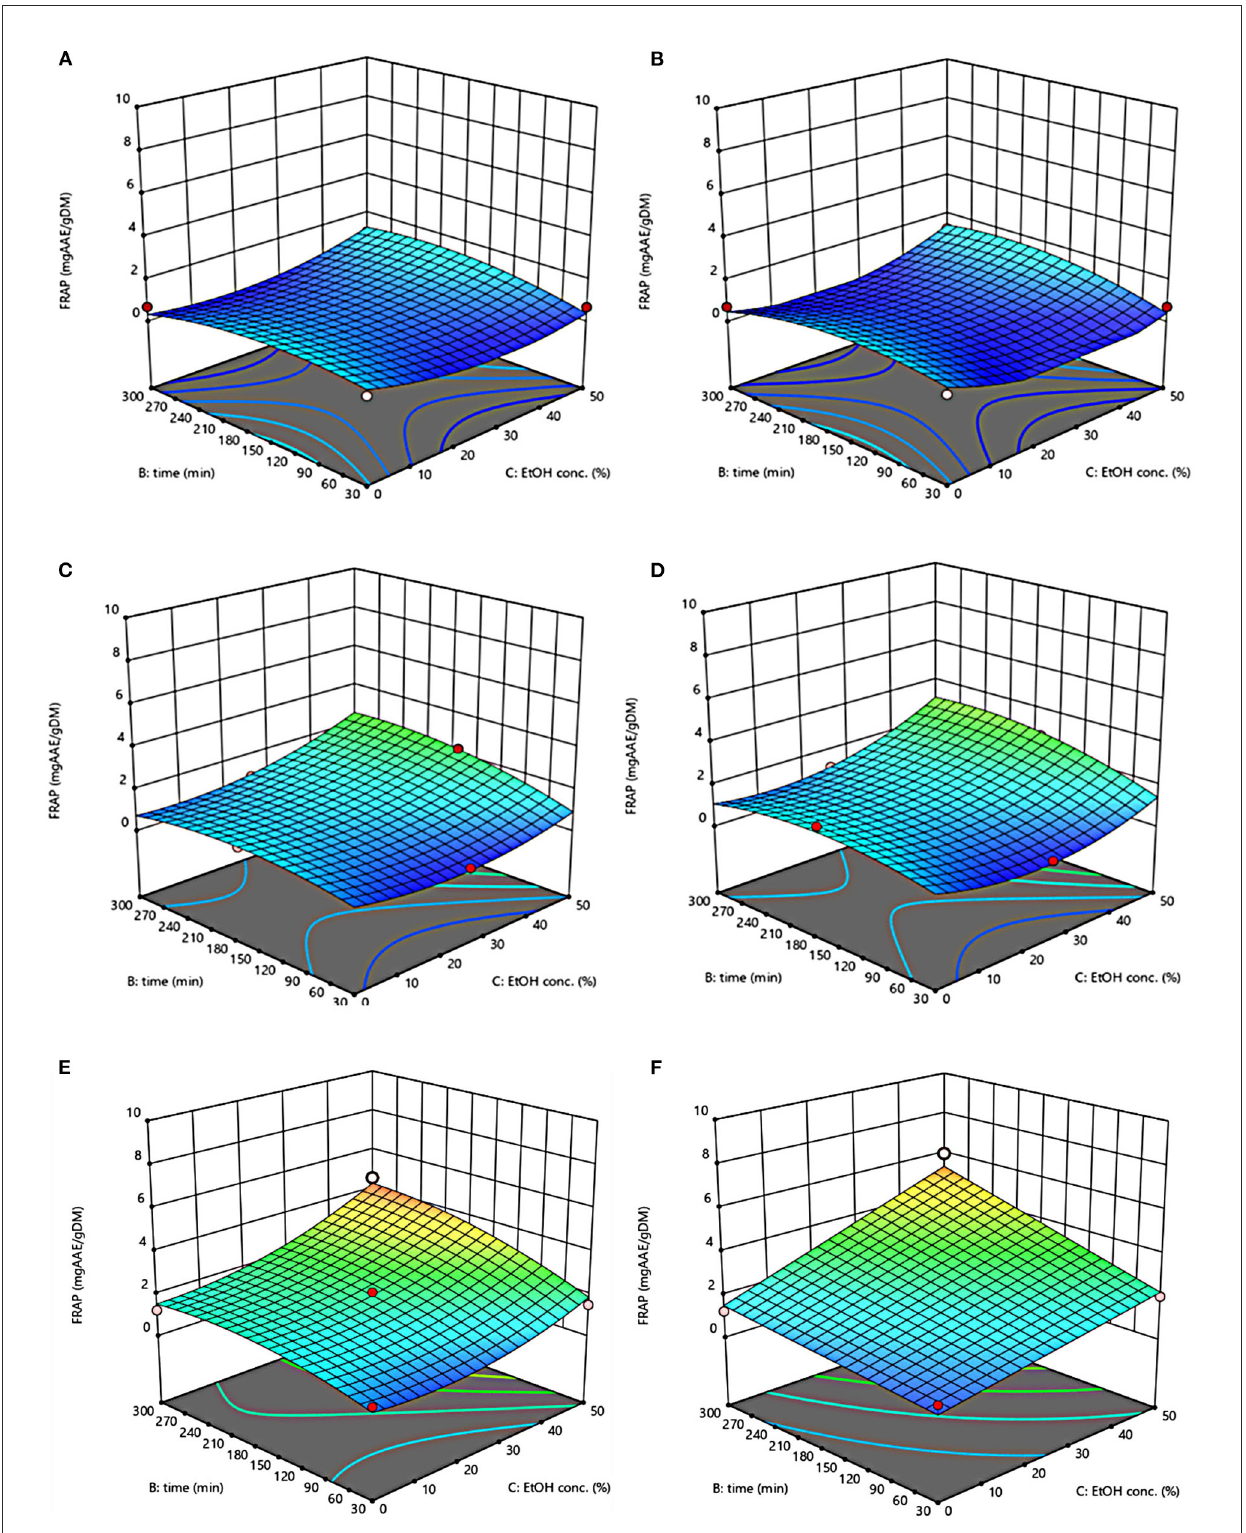
FIGURE6 Response surfaces of antioxidant activity (FRAP) of extracts from untreated (Control) (A, C, E) and PEF-treated (E = 4.6 kV/cm; WT = 20kJ/kg) (B, D, F) grape pomace as a function of extraction time and ethanol concentration. Extraction temperature set at 20 ◦ C (A, B) , 35 ◦ C (C, D) , 50 ◦ C (E, F) .